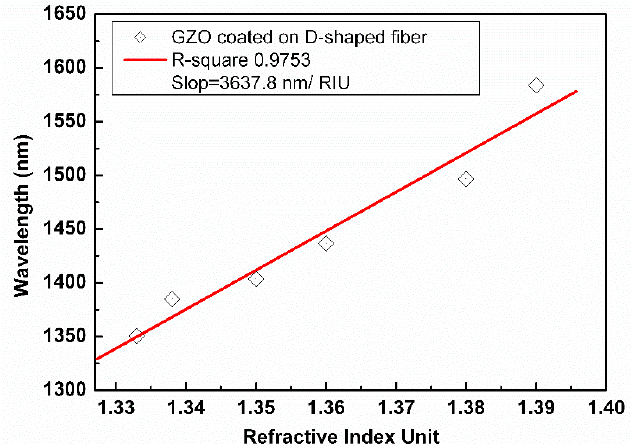
Figure 7. The sensitivity of the LMR type liquid refractive index sensor.